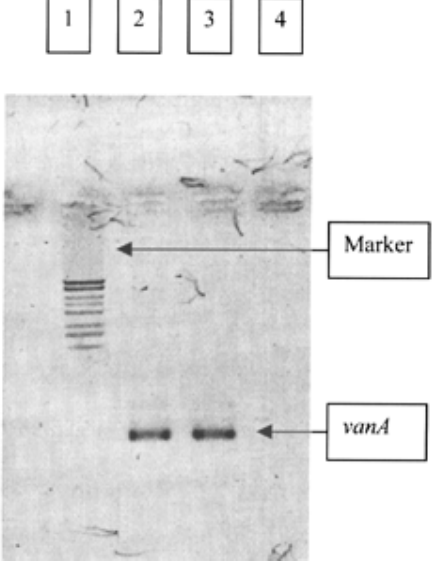
Figure 4. Specific PCR amplification of vanA gene of the first vancomycin-resistant Enterococcus faecalis strain in